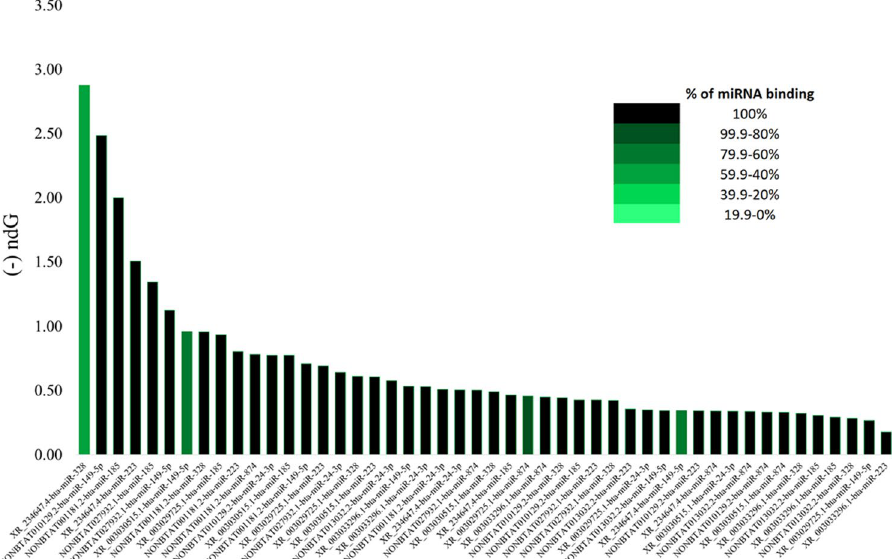
Figure 7. miRNA-lncRNA predicted binding with their normalized binding free energy (ndG). The black bars indicate the entire miRNA binds to the lncRNA; the lighter the green bar, the less complementary basing between miRNA and lncRNA. Figure created with Microsoft Excel (2013).